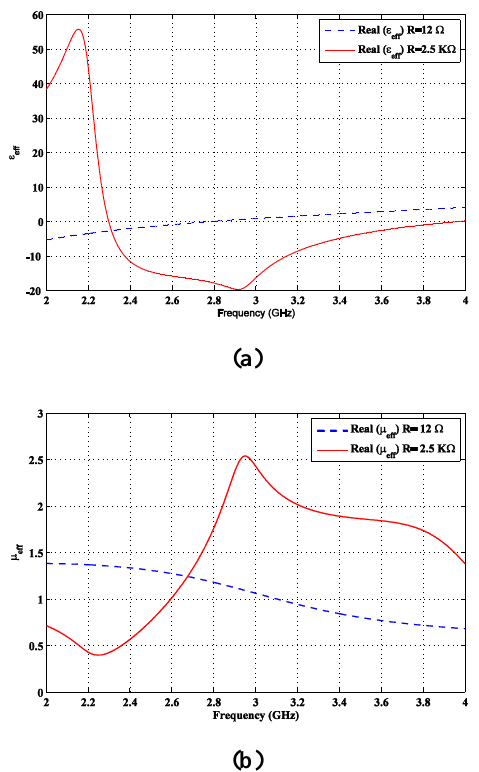
Figure 4: Real parts of permittivity (a) and permeability (b) parameters at two reflection and transmission